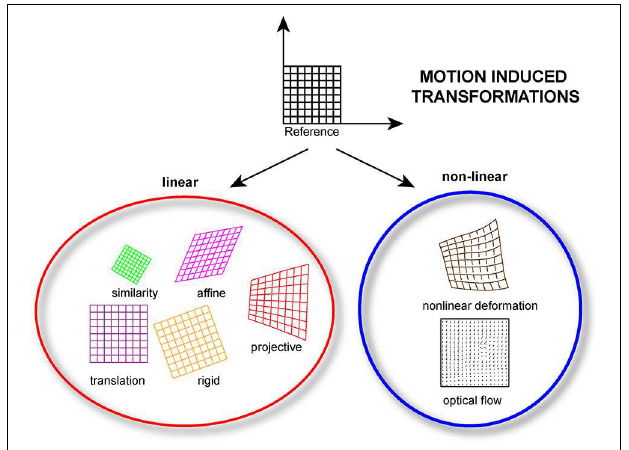
FIGURE 3 | Various types of passive stabilizers. (A) Holding stabilizers consist generally of an arm and a coverslip. The arm constrains the horizontal movements while the coverslip limits the vertical component of the motion. This type of stabilizer (compressive) has been demonstrated with good results in particular for kidney or liver imaging. However, it is not suitable for heart imaging because heart movement is very large in displacement and mechanically stiff. The strong pressure that would be required for heart immobilization using this type of stabilizer would easily affect the physiology leading to heart arrest. Adapted from Lee et al. (2012b). (B) Adhesive based mechanical stabilizers can immobilize the mouse heart sufficiently without relying on strong pressure application. Adapted from Lee et al. (2012a). (C) Alternatively, a suctioning mechanical stabilizer based on mild negative pressure has been shown to immobilize the beating mouse heart with optimal motion artifacts suppression. Adapted from Vinegoni et al. (2012). (D) Images of intravital imaging setups using the stabilizer as shown in